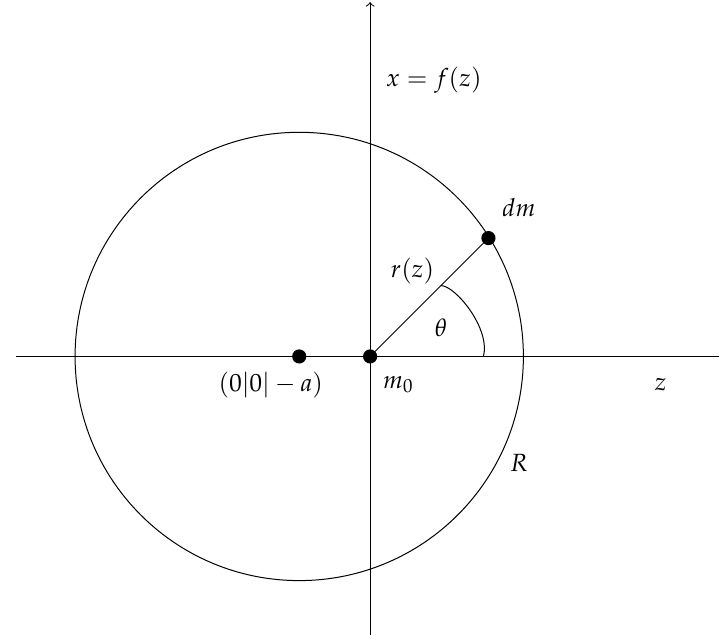
Figure A1. Simple example for the check of Assumption